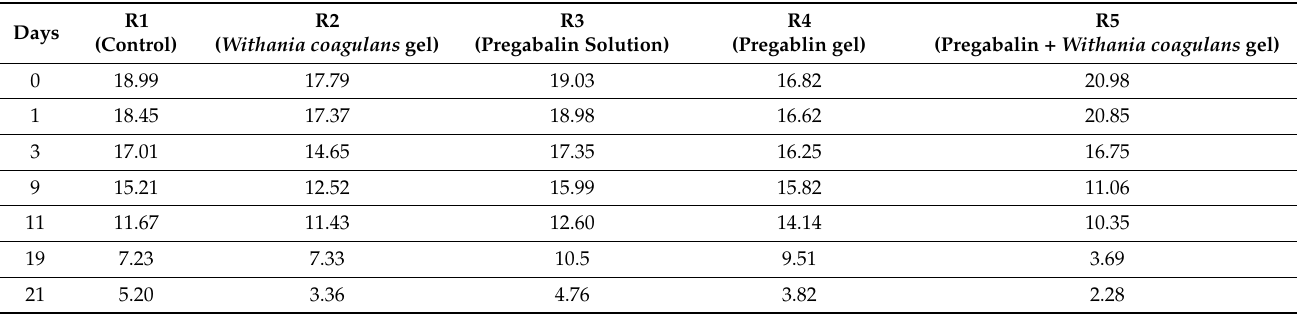
Table 4. Wound surface area (mm) changes at measurement days of different groups, n =